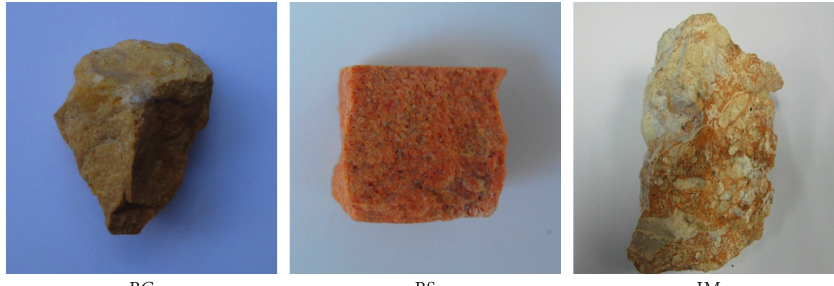
Figure 1: Image of the studied raw